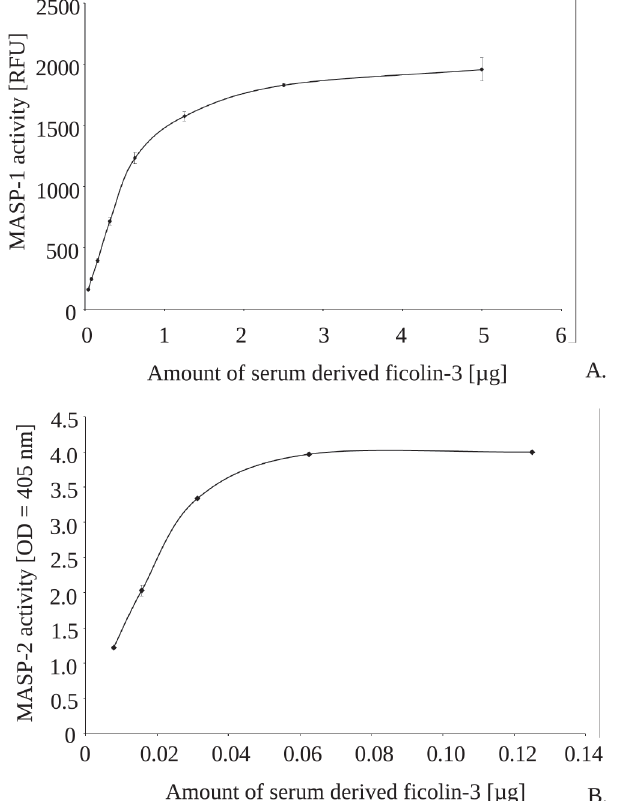
Fig 5. Concentration-dependent activity of plasma-derived ficolin-3/MASP-1 and ficolin-3/MASP-2 complexes to activate LP. (A) MASP-1 activity is expressed as the fluorescence of a product emerging due to the capacity of MASP-1 to cleave VPR-AMC substrate. (B) MASP-2 activity was determined by detection of C4 activation products deposition assay by specific antibodies. Conditions excluding activation of complement classical pathway were applied (Petersen et al., 2001).